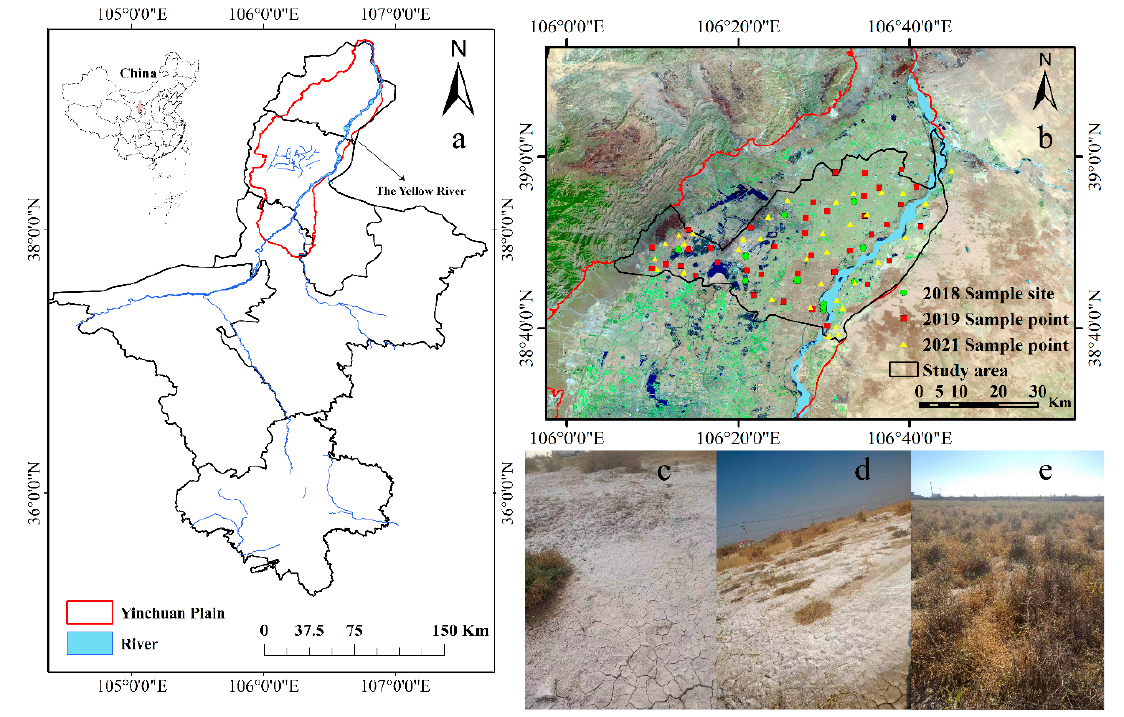
Figure 1. Locations of the Yinchuan Plain, China ( a ), distribution of sampling ( b ) sampling sites in 2018 (green circle), 2019 (red square) and 2021 (yellow triangle), and typical landscape photographs ( c – e ).